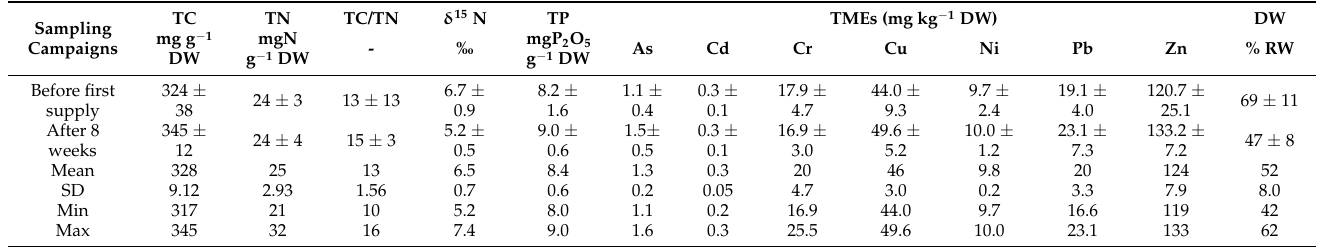
Table 3. Physico-chemical data ( ± CI, n = 3) of solid samples from the biopile substrate; Min and Max: the values measured during the trial for each parameter ( n = 12, except for TP, TMEs, and before the supply).